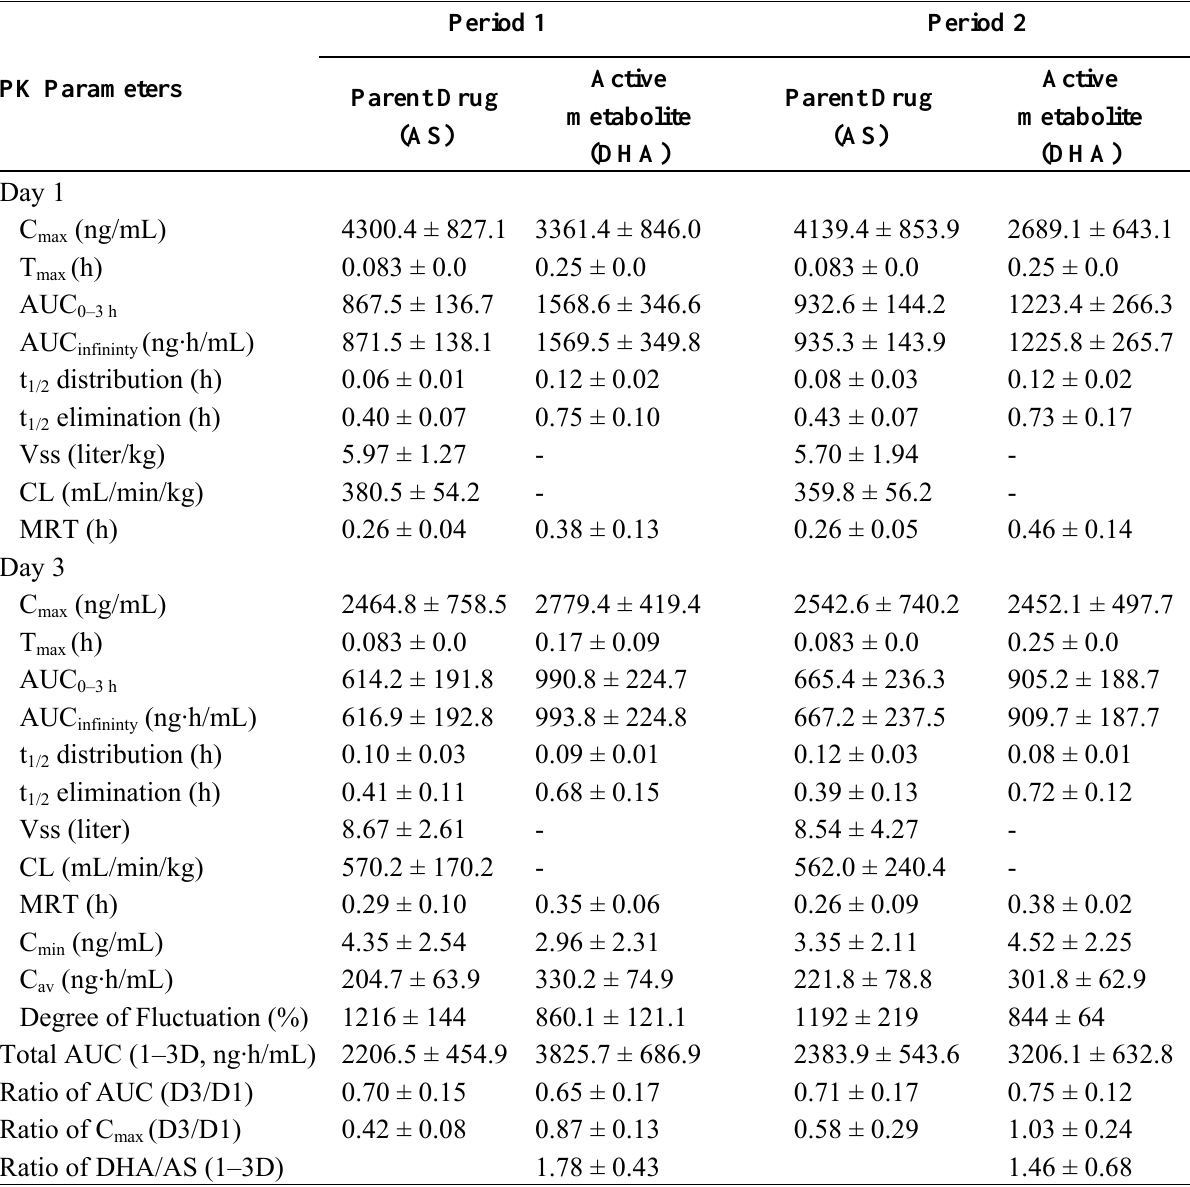
Table 1. Pharmacokinetic parameters of artesunate (AS/NaHCO dihydroartemisinin (DHA), an active metabolite of AS, at dose of 20 mg/kg following single and multiple intravenous injection daily for three days in male rats in two-period (n =